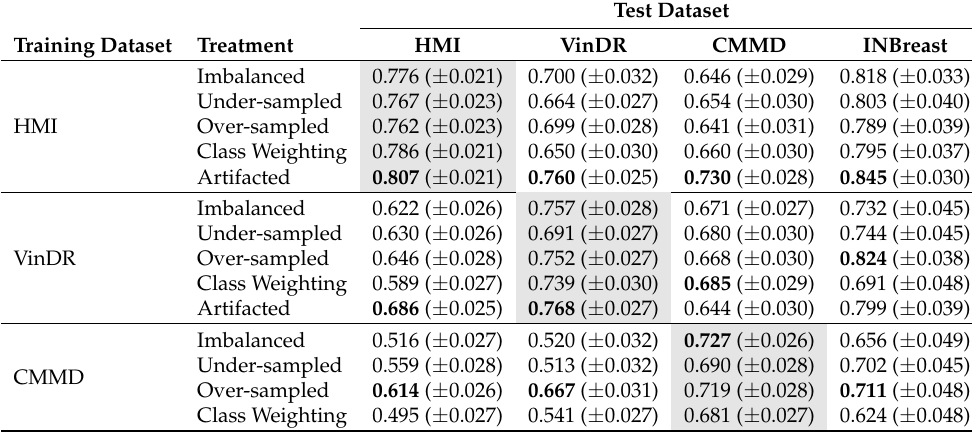
Table 2. AUC ( ± standard error) for each combination of training data and test data, for the var- ious experimental treatments. Shaded are results where the training and test sets are from the same